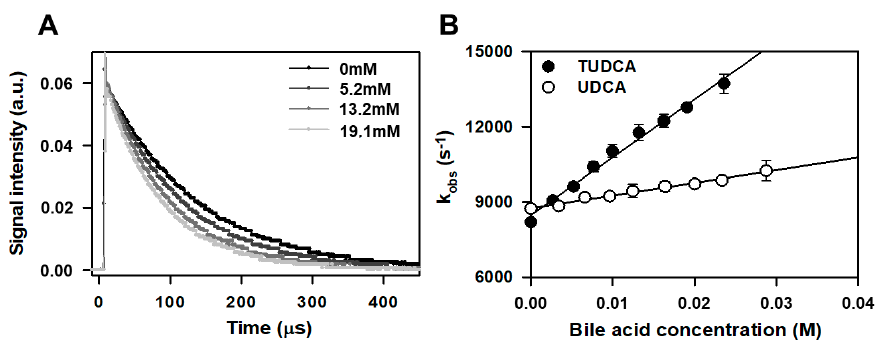
Figure 2. Singlet oxygen phosphorescence decays at 1270 nm acquired in TPP solution in DMSO– d6:CHCl 3 (1:1, v/v) upon excitation with 590 nm laser pulse in the absence and in the presence of